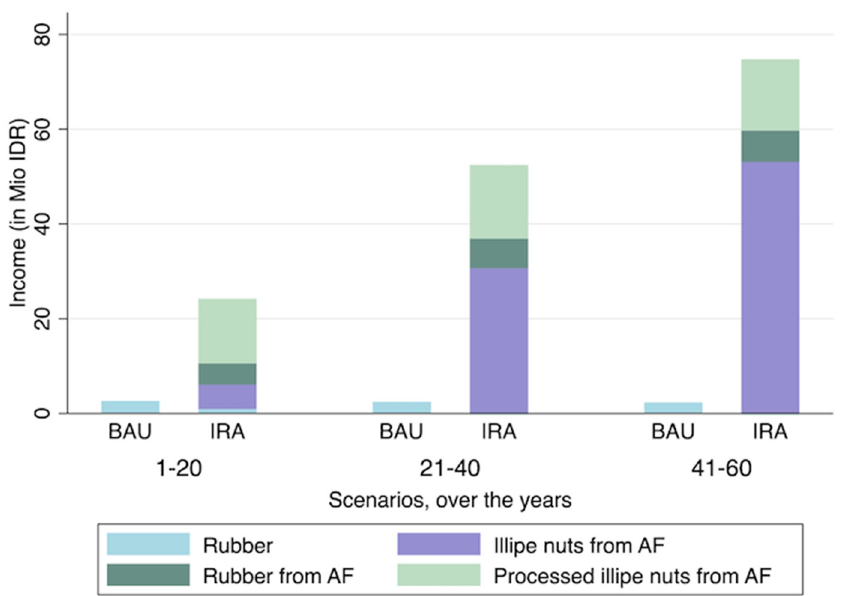
Figure 8. Simulation results: generated cash income over time.